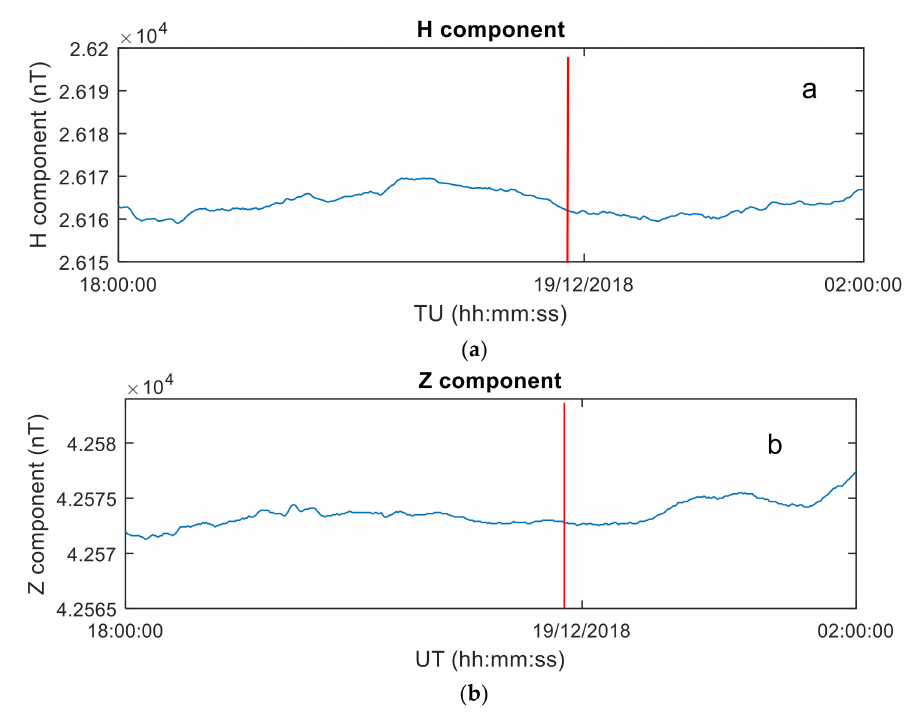
Figure 4. Geomagnetic observation at Memambetsu Station on 18 December 2018, 18:00:00 UT–18:00:00 UT. ( a ) Earth level component (H component) observations. ( b ) the geomagnetic vertical component (Z component). The red line is the moment of the meteor